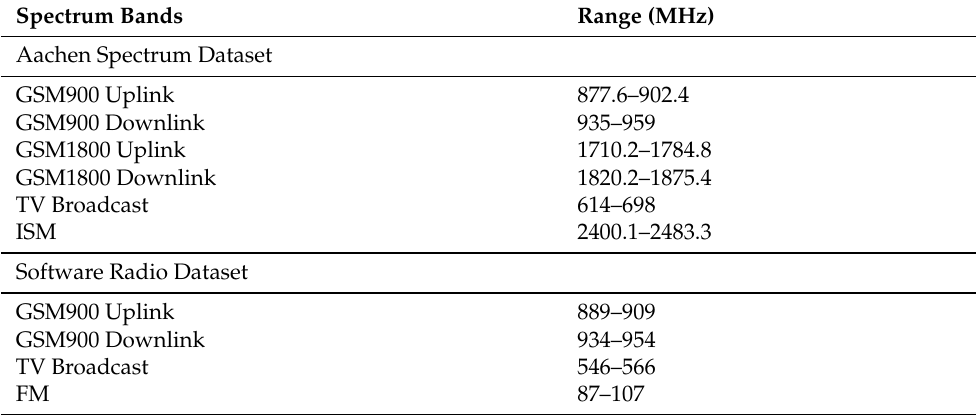
Table 1. Spectrum Datasets Used in This